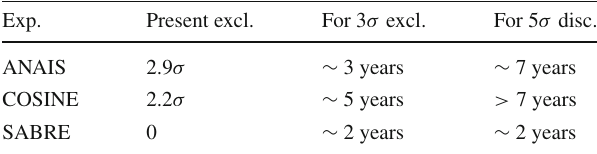
Table 3 Present exclusion C.L. for the detectors, and years for signif- icant exclusion (Fig. 7) and discovery CL (Fig. 8) Exp. Present excl. For 3 σ excl. For 5 σ disc.